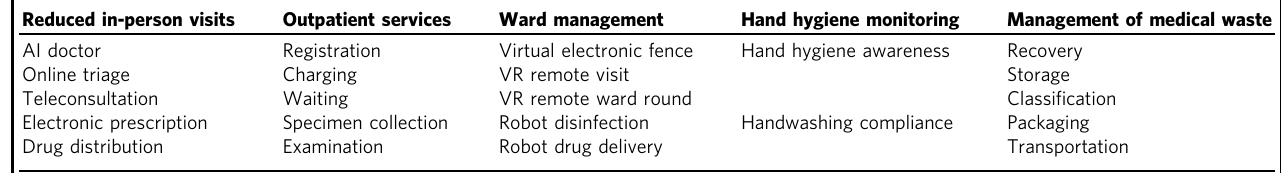
Table 1 The key information technology components that might impact nosocomial infections. Reduced in-person